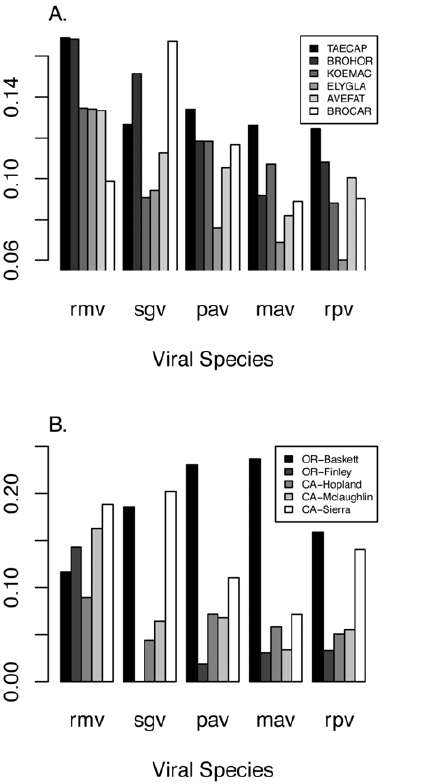
Figure 1. Prevalence of five plant viruses in (A) six grass hosts: Avena fatua (AVEFAT), Bromus carinatus (BROCAR), Bromus hordeaceus (BROHOR), Elymus glaucus (ELYGLA), Koeleria ma- crantha (KOEMAC), and Taeniatherumcaput-medusae (TAECAP), and (B) at five study sites in Oregon and California.